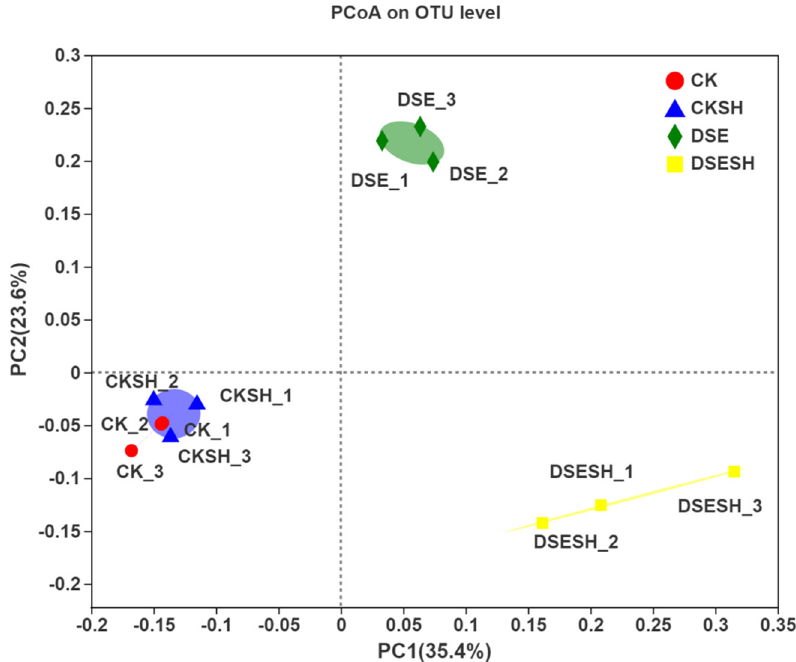
Figure 5. PCoA ordination according to the Bray-Curtis similarities for bacterial communities in CK, CK + SH, DSE, DSE + SH treatments. CK: inoculation with cottonseed shell blank culture medium. DSE: single inoculation with P. bamuru A024. CK + SH: Single inoculation with R. solani SH01. DSE